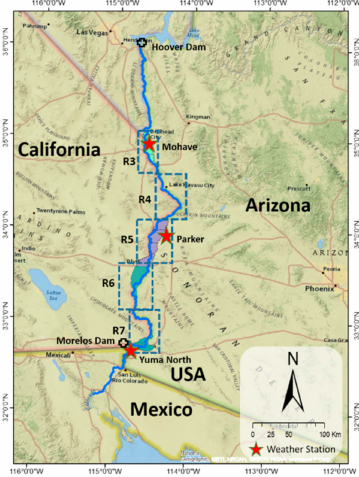
Figure 1. Study area divided into five riparian zones (R3 to R7) outlined in dashed boxes on the Lower Colorado River between Hoover Dam and Morelos Dam on the border of the U.S. and Mexico, with the two dams shown (black circle symbol) and three Arizona Meteorological ground stations (AZMET) used for the weather variables collected over the 21 year study (red